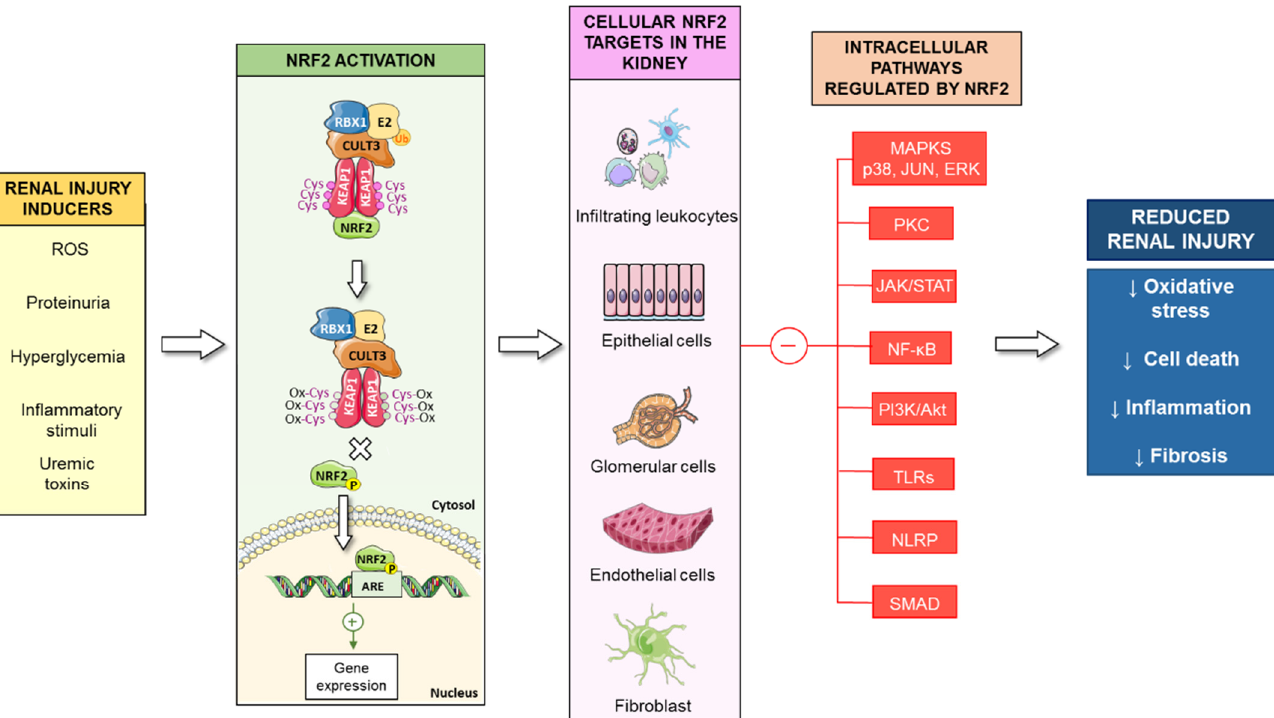
Figure 3. Activation of the Nrf2 signaling pathway in kidney diseases. Several nephrotoxic stimuli, such as ROS, proteinuria, hyperglycemia, uremic toxins, or inflammation, promote Nrf2 activation in the kidney (fibroblasts, infiltrating leucocytes, tubuloepithelial, glomerular and endothelial cells). Activated Nrf2 induces the expression of phase II enzymes and inhibits the activation of intracellular pathways associated with renal injury (MAPKs, p38, JUN, ERK, JAK/STAT, NF- κ B, TLRs), reducing oxidative stress, cell death, inflammation, and fibrosis.